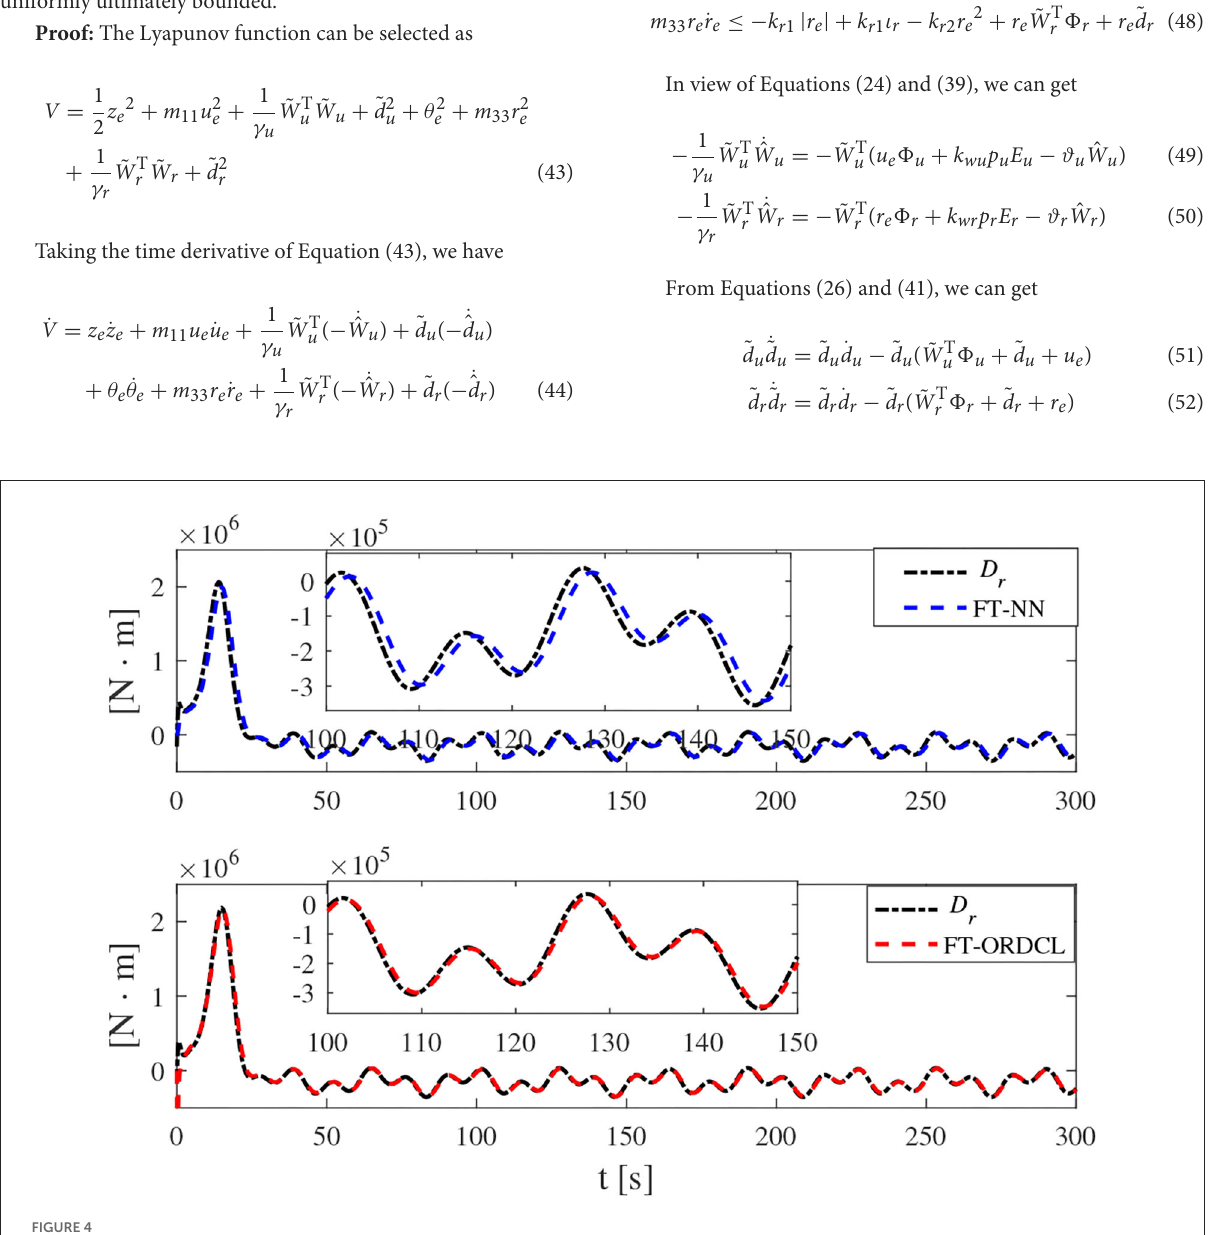
FIGURE4 D r and its estimation in Case